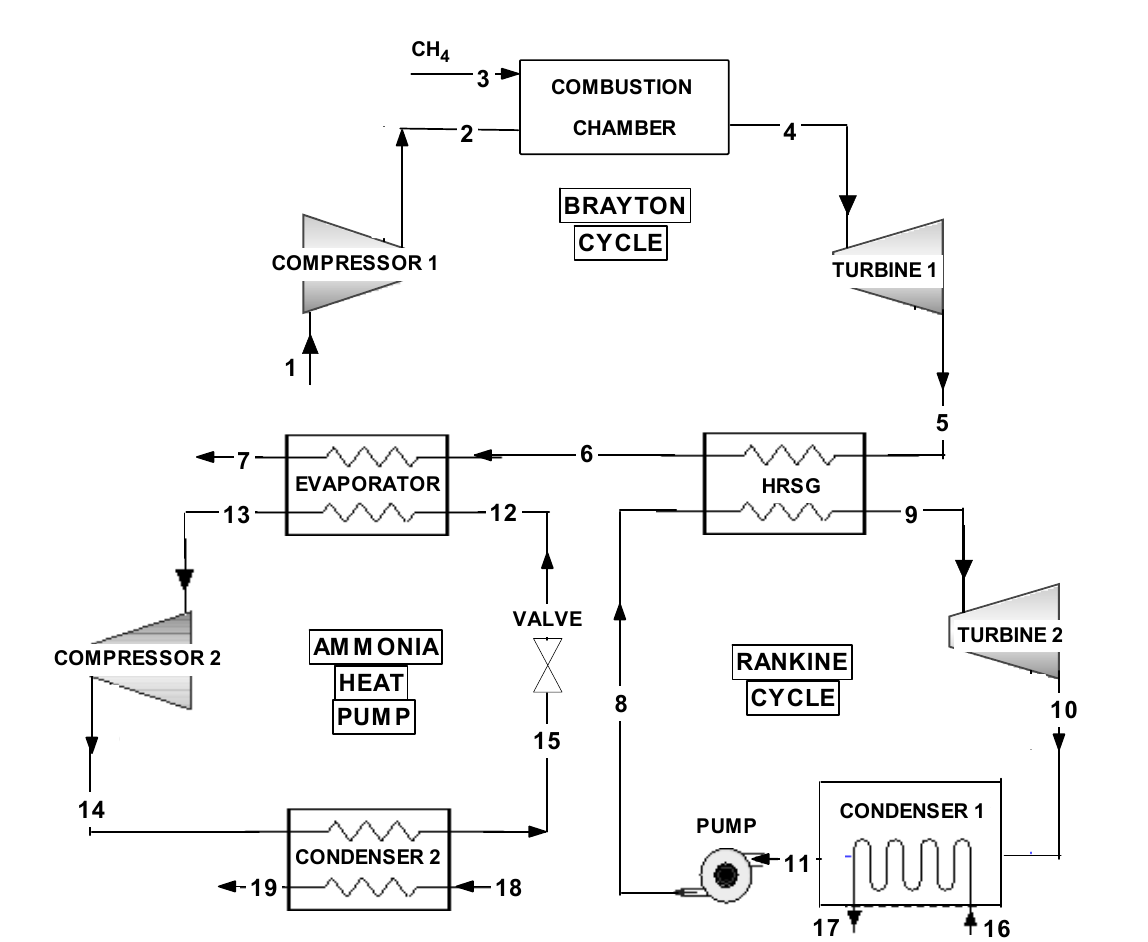
Figure 1. Model diagram of the multigenerational system.